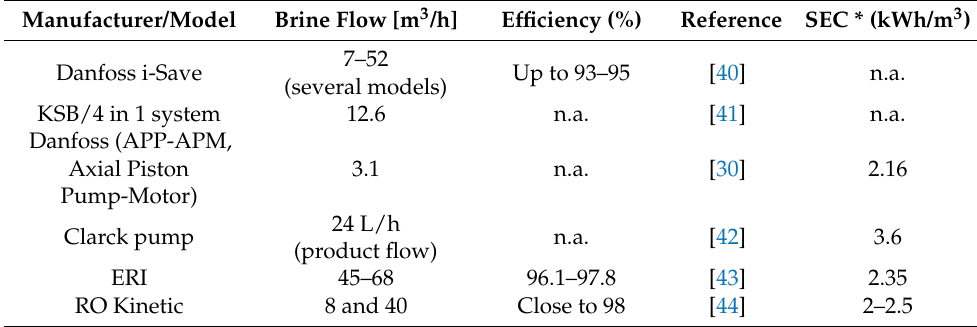
Table 5. Summary of the energy recovery